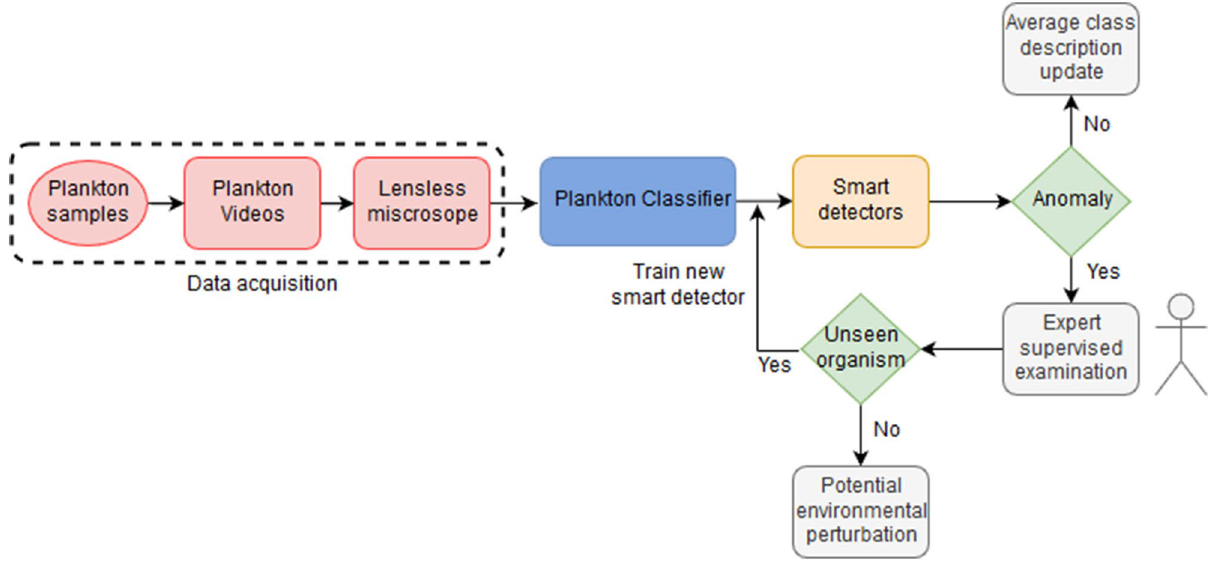
Figure 5. Proposed real-time smart environmental monitoring